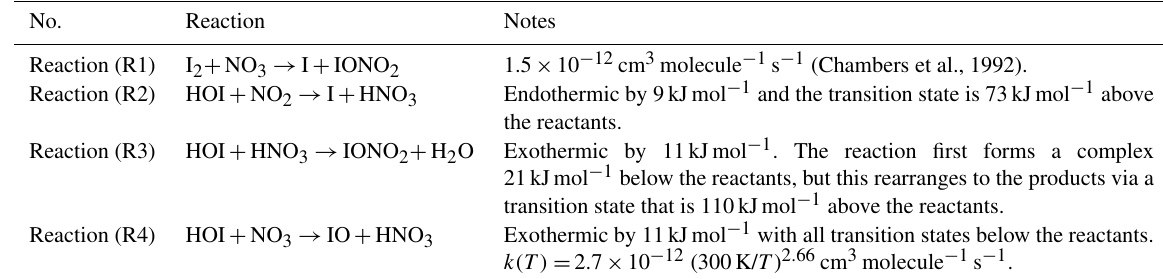
Table 1. Nighttime reactions of emitted inorganic iodine compounds considered in addition to the iodine chemistry scheme used by Saiz- Lopez et al. (2014).